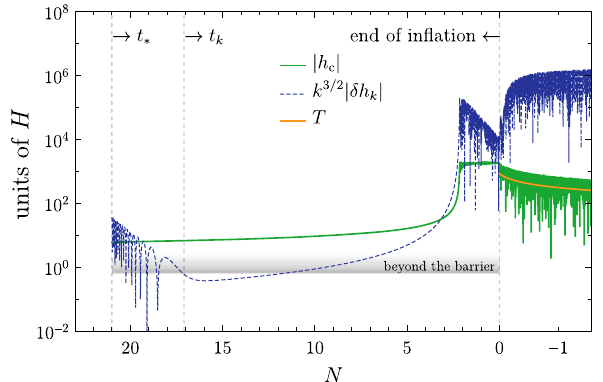
Fig. 3 Power spectrum P ζ as a function of the starting value N ∗ , for a fixed h ∗ = 6 . 11 H . The green line corresponds to a PBH abundance roughly oforder unity, and thegrey lines, yieldingno PBHs, correspond to the cases shown in Fig. 4